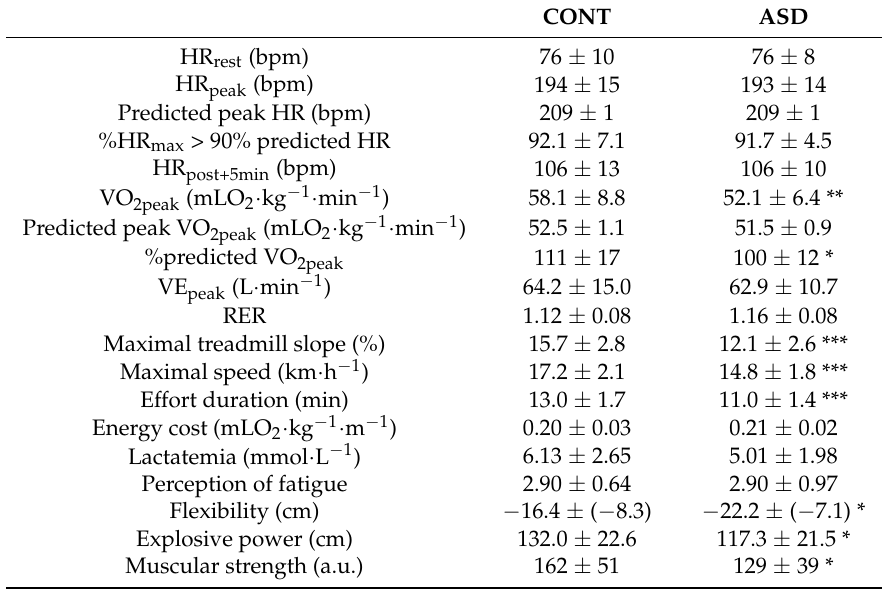
Table 2. Results of maximal treadmill test, motor assessment data.